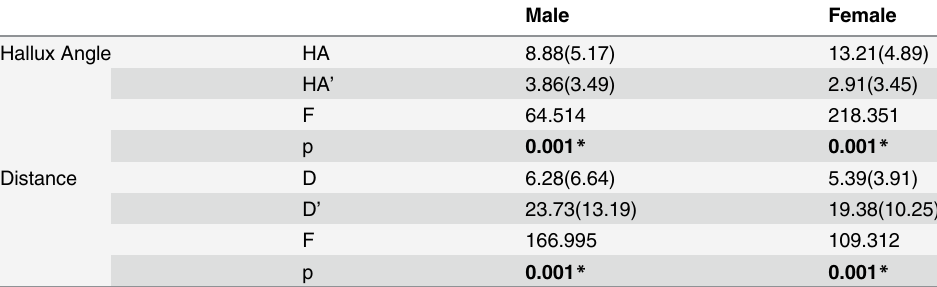
Note: HA-the hallux angle value of shod feet, HA ’ -the hallux angle value of unshod feet; D-the minimal distance between hallux and second toe of shod feet; D ’ -the minimal distance between hallux and second toe of unshod feet, * indicates signi fi cance between unshod and shod